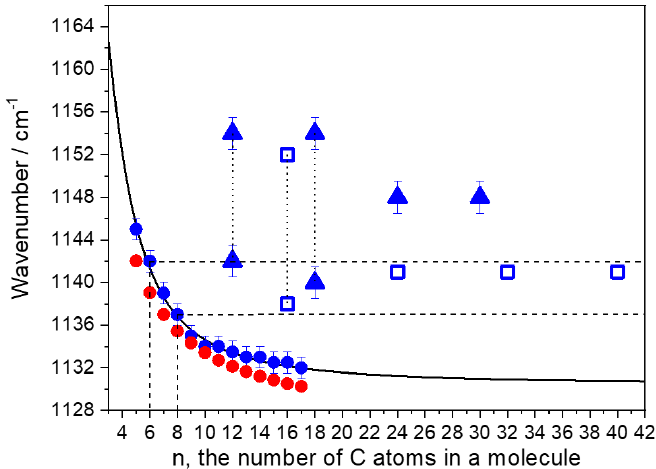
Figure 6. Peak position of the C–C mode for the hydrogenated 1-hexene ( ▲ ) and 1-octene ( □ ) oligomers as well as for linear alkanes ( ● , ● ) versus the number of carbon atoms in a molecule. Symbols ▲ , □ , ● are the observed wavenumbers, symbols ● are the DFT wavenumbers, the solid curve is the theoretical law for linear alkanes at ν ∞ = 1130.5 cm − 1 and β = 313 cm − 1 (see text: Equation (2)). The vertical dotted lines drawn through triangle or square symbols connect the data attributed to the particular substance of the H2H, H3H, or O2H compounds (see Table 1 and Figure 5). The measurement errors of the peak positions are also indicated.